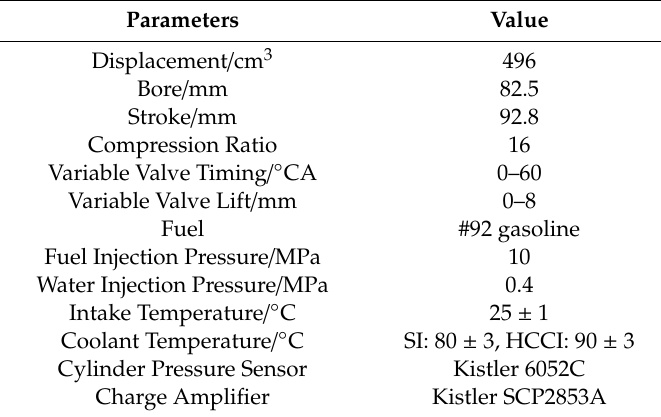
Table 2. Specifications of test engine and pressure sensor.